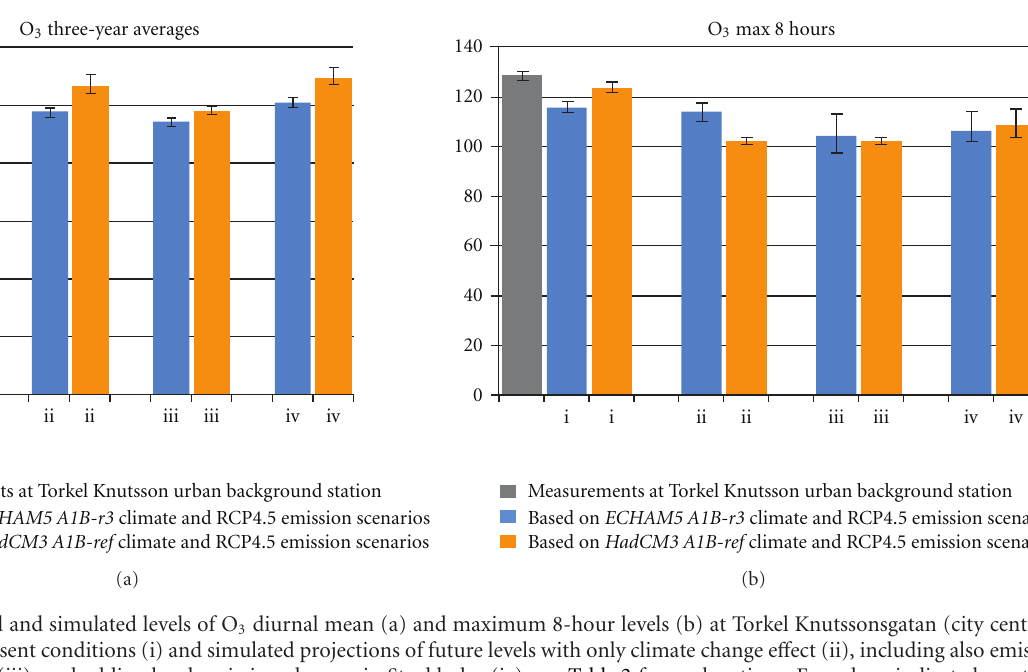
Figure 5: Observed and simulated levels of O 3 diurnal mean (a) and maximum 8-hour levels (b) at Torkel Knutssonsgatan (city centre of Stockholm), for present conditions (i) and simulated projections of future levels with only climate change e ff ect (ii), including also emission changes in Europe (iii), and adding local emission changes in Stockholm (iv), see Table 2 for explanations. Error bars indicate lowest and highest annual average value of the three years. Unit: µ gm − 3 . Simulated concentrations are bilinearly interpolated to the location of the monitor